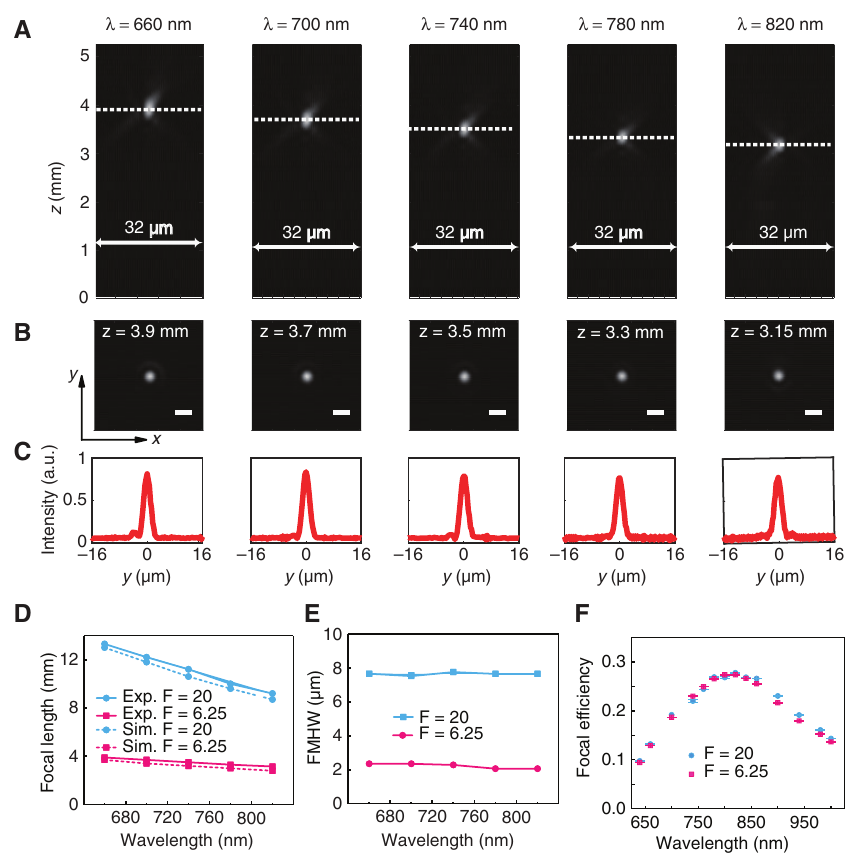
Figure 3: Focusing properties of the Cassegrain metasurface telescope with F = 6.25 at a wavelength of 780 nm. (A) The measured intensity profiles along the propagating axial plane at various incident wavelengths. The white dashed lines indicate the position of the focal points. (B) The measured intensity profiles at the focal plane (scale bar: 5 μ m). (C) The corresponding cross-sections of the focal spots along y direction. (D–F) The simulated and experimentally measured focal length (D), measured FWHW (E), and measured focal efficiency (F) spectra with respect to the wavelength of incident